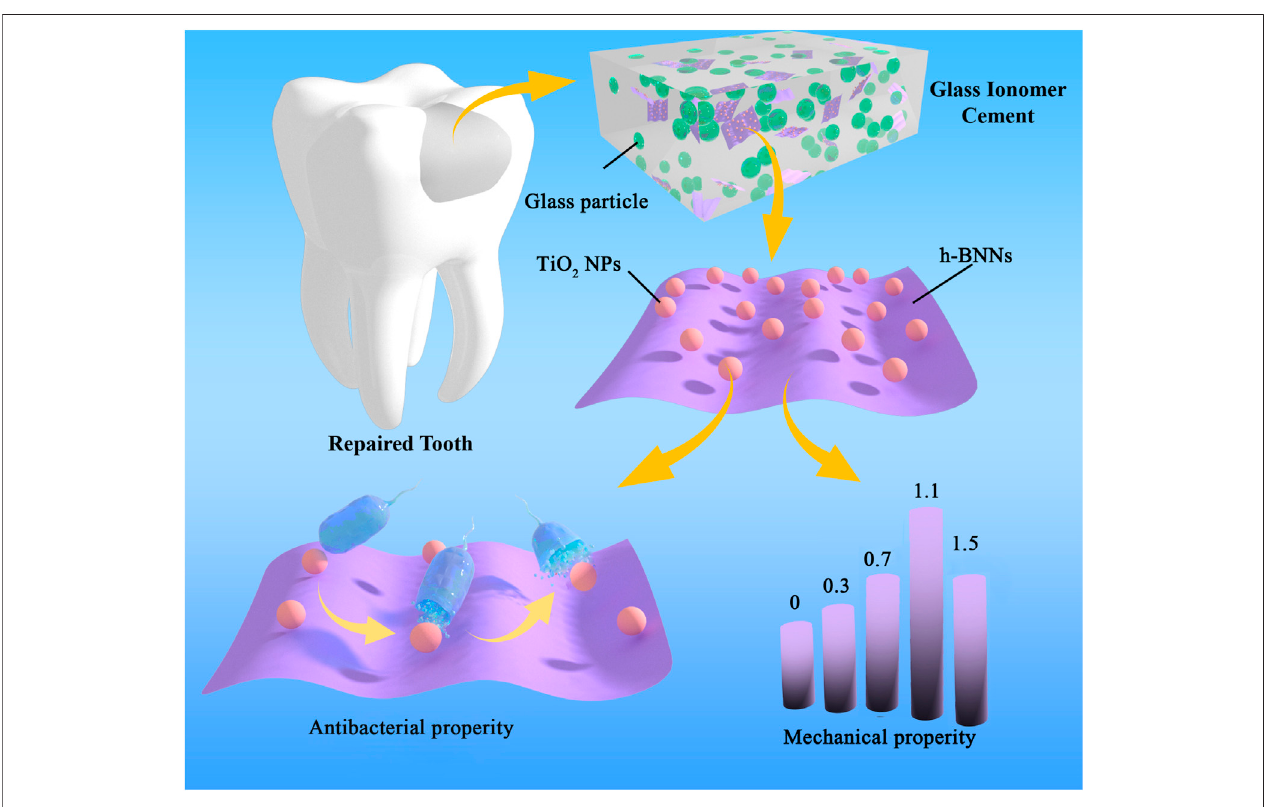
FIGURE 1 | Schematic diagram of synthesis and performance evaluation h-BN-TiO 2 /GIC composites.